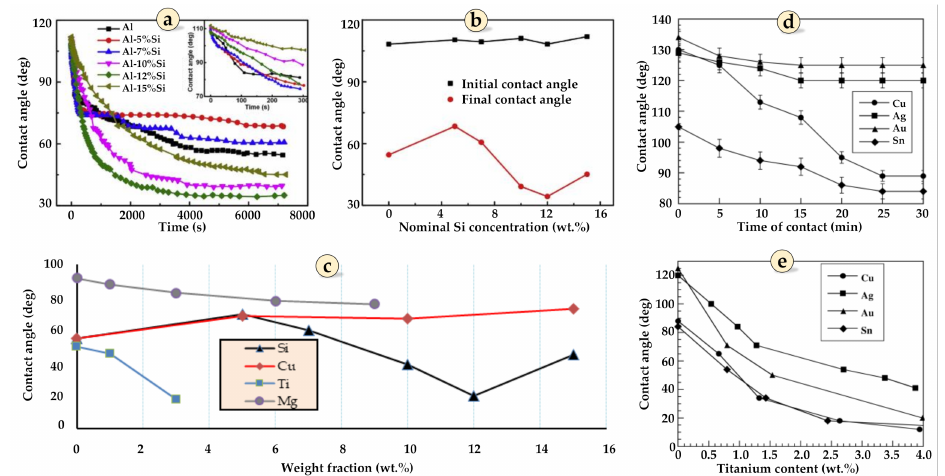
Figure 9. ( a ) Contact angle in SiC-Al system with different contents of Si alloying element, ( b ) initial and final (equilibrium) contact angles of SiC/Al reproduced from [30] with permission of Elsevier, 2019. ( c ) the effect of different alloying elements on the wetting angle of SiC/Al composite. ( d ) the effect of Ti alloying element on wetting between TiC and ( e ) different alloys of Cu, Ag, Au and Sn re produced from [137], with permission of Elsevier,